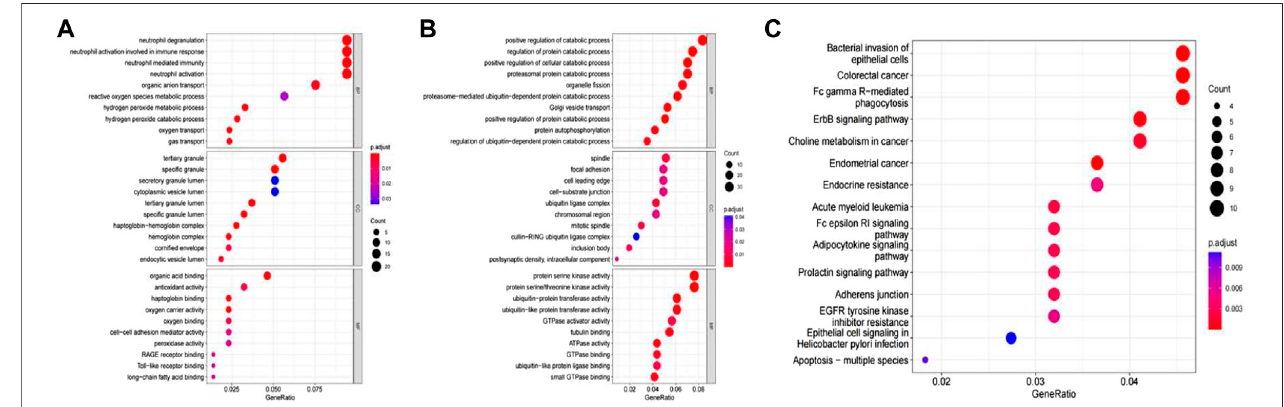
FIGURE 3 | (A) Enriched analysis of differentially expressed mRNA in GO; (B) Enriched analysis of differentially expressed circRNA in GO; (C) KEGG analysis of differentially expressed